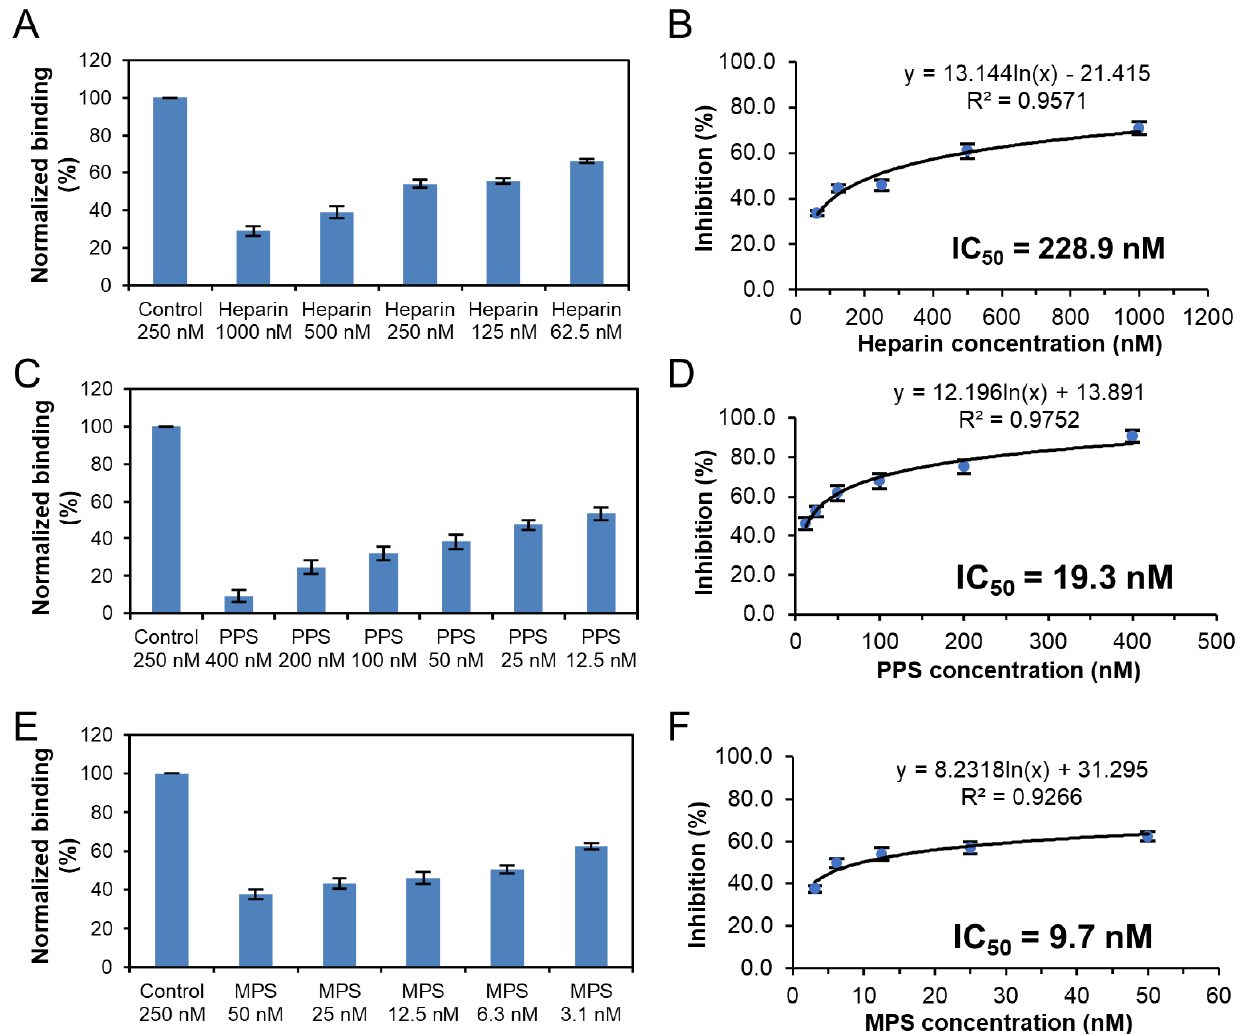
Figure 7. IC 50 measurement of the inhibition of S-protein RBD (BA.2.12.1) binding to heparin using solution competition SPR by sulfated glycans (heparin, PPS, and MPS). S-protein RBD concentra- tion was 250 nM. Error bars represent standard deviations from triplicate tests. ( A , B ) = heparin; ( C , D ) = PPS; ( E , F ) =